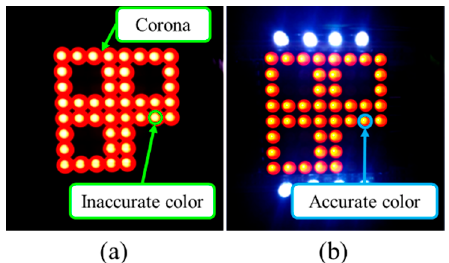
Figure25. CameracaptureframeofIAC: ( a )corona / bloomingcausinginter-pixelinterference; ( b )correct Figure 25. Camera capture frame of IAC: ( a ) corona/blooming causing inter-pixel interference; focus and accurate color interpretation ( b ) correct focus and accurate color interpretation [22].